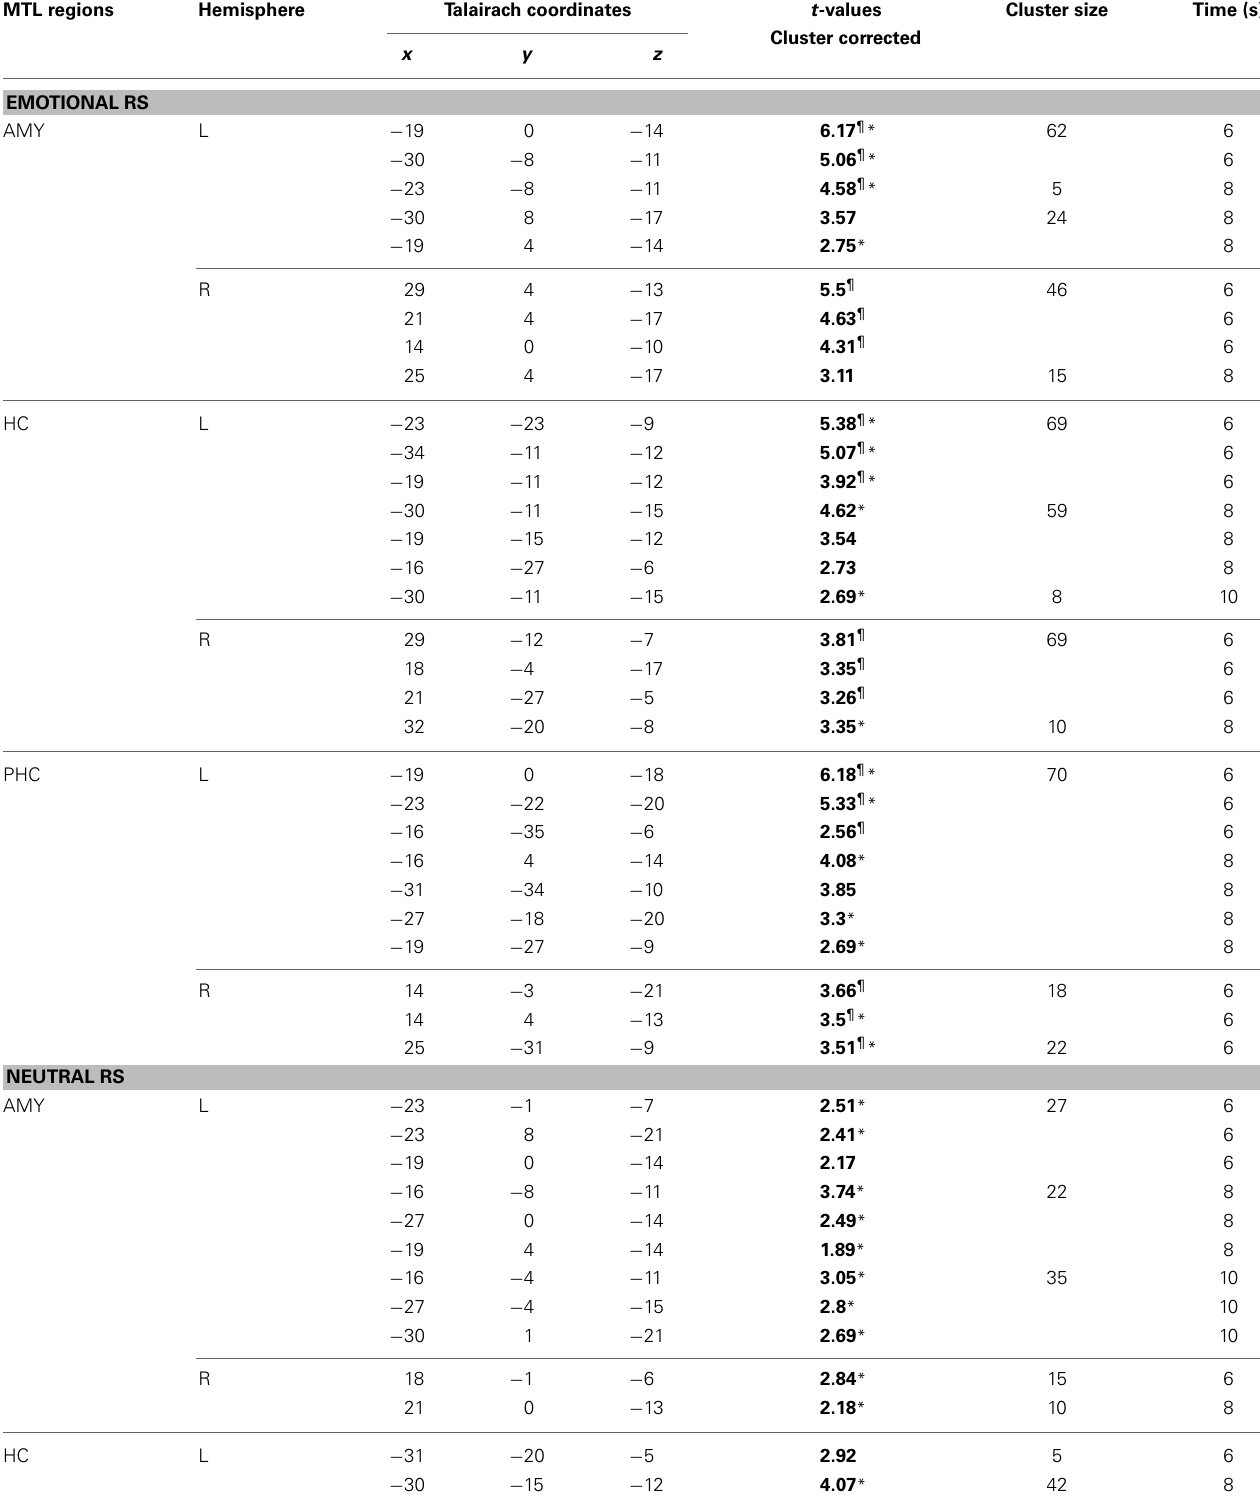
Table 1 | MTL regions engaged in emotional and neutral retrieval success. MTL